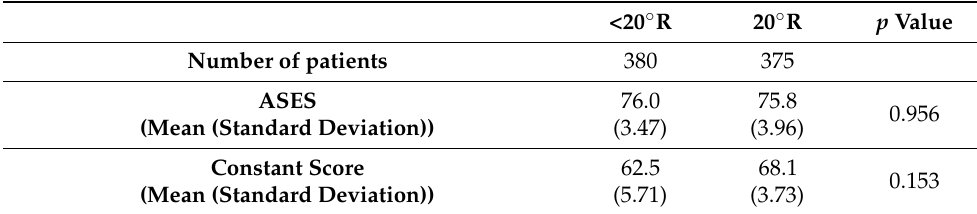
Table 3. Comparison of Groups 1 and